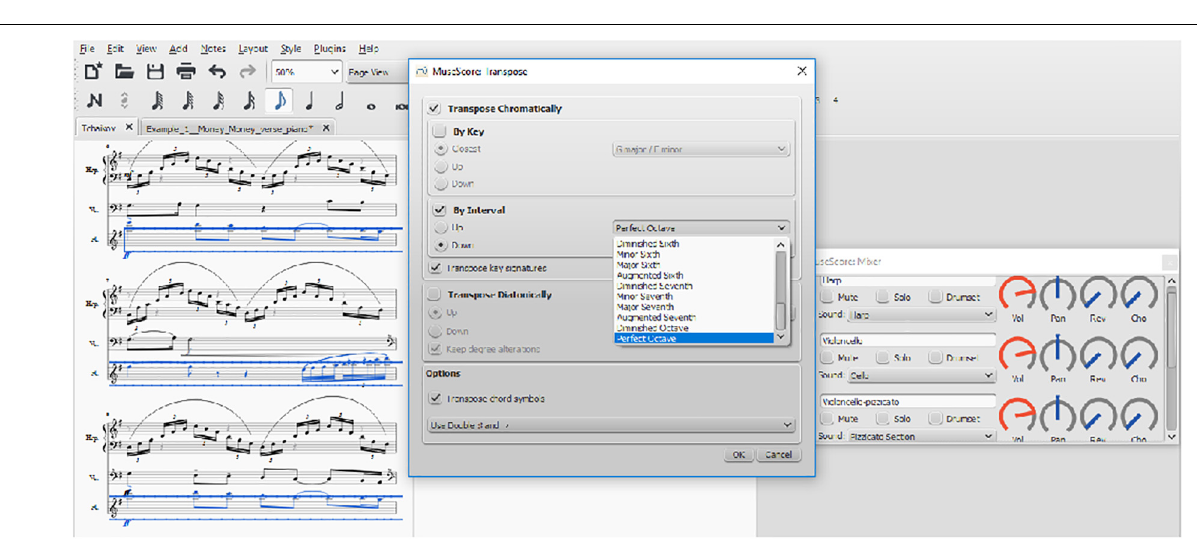
FIGURE 12 | A reduction of Pas de Deux in MuseScore’s notation view.